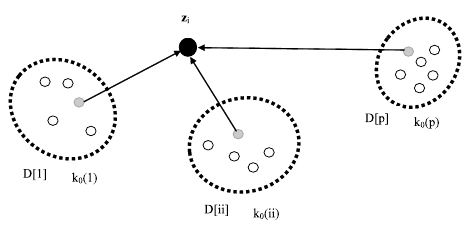
Figure 5. The determination of correspondence between z i and the prototypes in D[1], D[2], …, D[p] identified as having the highest level of matching More specifically, for each ii we compute the membership degrees u ( v [ii])) and find the i k